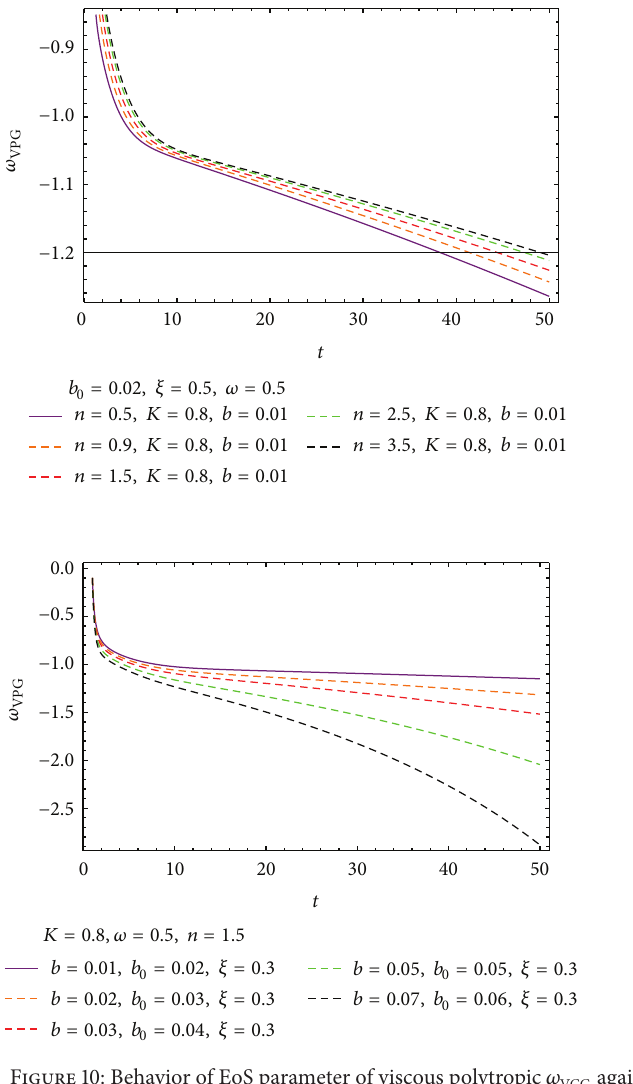
From the second plot we find that increasing 𝜔 increases 𝜔 . Also it is clear from this plot that evolution of total tot equation of state parameter corresponding to low values of 𝜔 is faster than that corresponding to higher